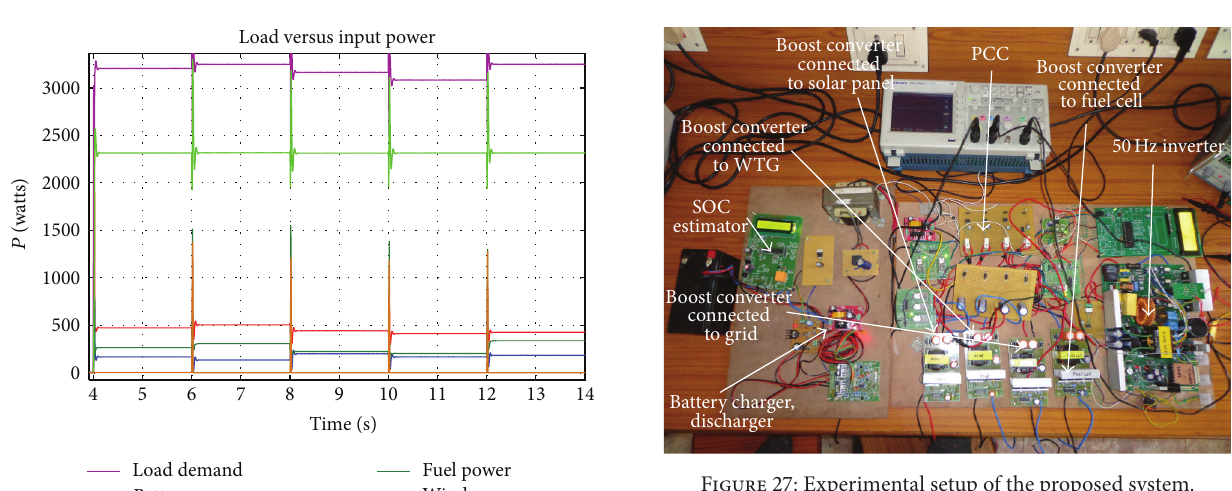
Figure 27: Experimental setup of the proposed system.